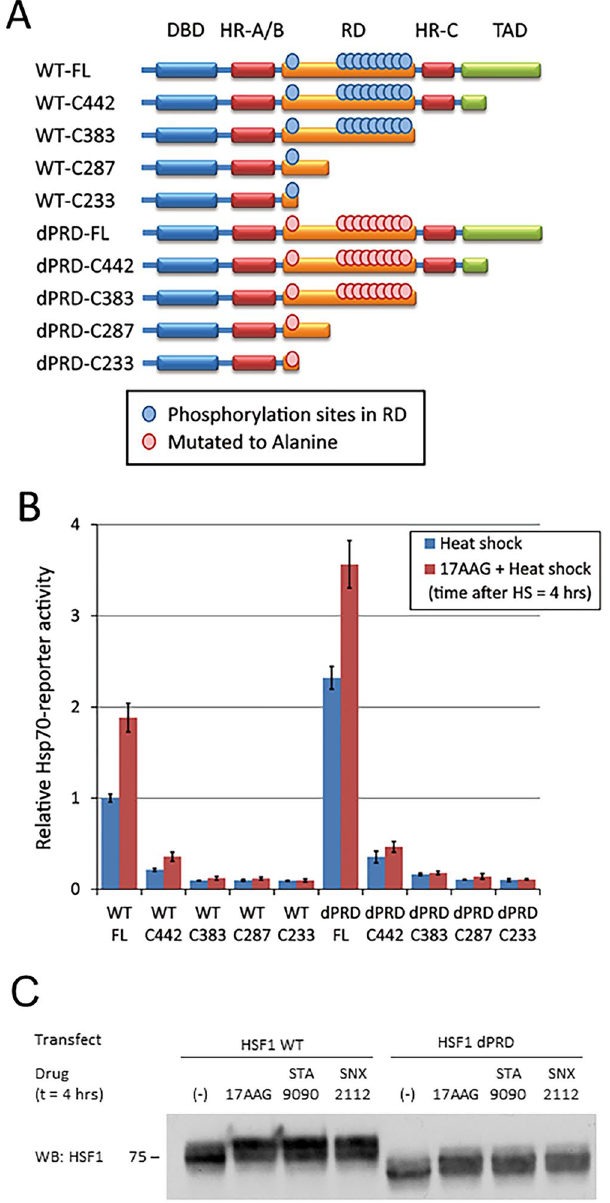
Figure 4. Impact of RD phosphorylation on HSP90 inhibitor effect on HSF1 activity and mobility shift in SDS- PAGE, and on HSF1 interaction with HSP90 ( A ) Schema of WT and dPRD FLAG-HSF1 constructs depicting RD phosphorylation sites mutated to alanine in dPRD-HSF1. ( B ) The N-terminal HSP90 inhibitor 17AAG enhances transcriptional activity of dPRD HSF1. HEK293 cells were transfected with hsp70 -reporter construct and HSF1 C-terminal truncation constructs, treated with DMSO or 17AAG for 1 hour, heat shocked at 42 °C for 30 minutes and allowed to recover for 4 hours before harvesting. This experiment was repeated three times and values represent mean + / − S.D. ( C ) N-terminal HSP90 inhibitors induce a mobility shift in dPRD HSF1 similarly to that seen with WT-HSF1. HEK293 cells were transfected with WT or dPRD HSF1, treated with the three N-terminal HSP90 inhibitors as shown, and harvested and HSF1 was analyzed by WB. Full blots used to create cropped figure panels are shown in Supplementary Figure